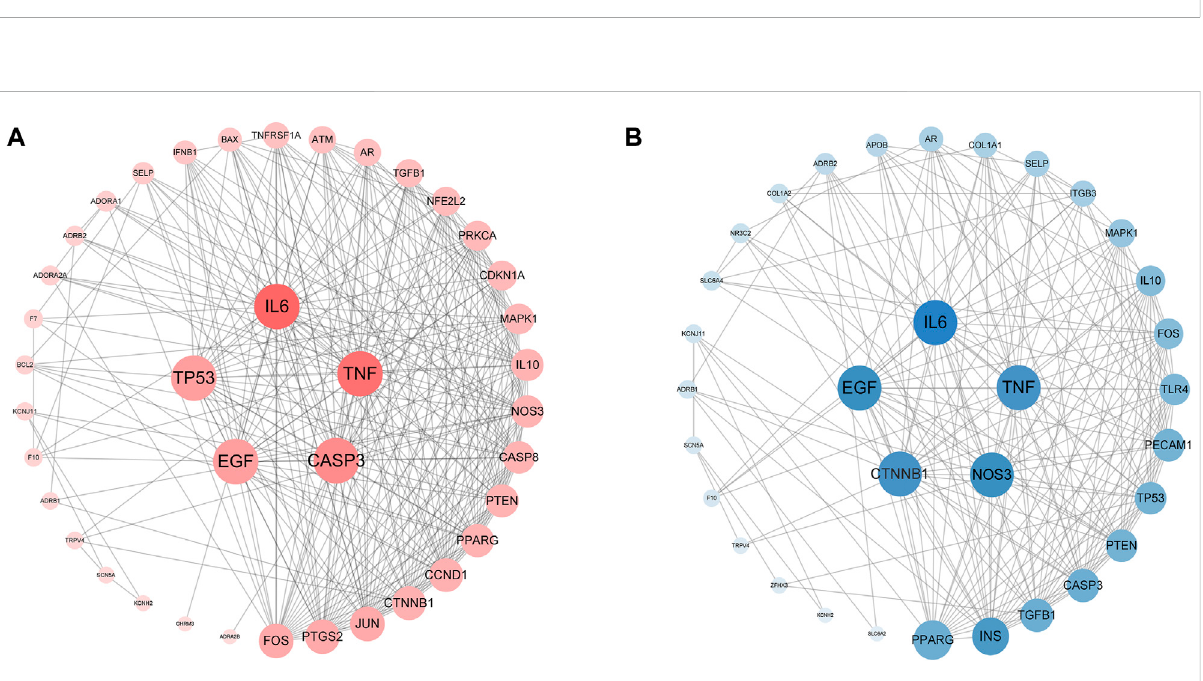
FIGURE 3 Protein – proteininteractionnetwork. (A) Thepinknodesrepresentthetargetsofbradyarrhythmia;thePPInetworkstructureofbradyarrhythmia has40nodesand321edges. (B) Thebluenodesrepresentthetargetsoftachyarrhythmia;thePPInetworkstructureoftachyarrhythmiahas33nodes and 207 edges. The sizes of the nodes of the two images are illustrated from large to small in descending order of degree